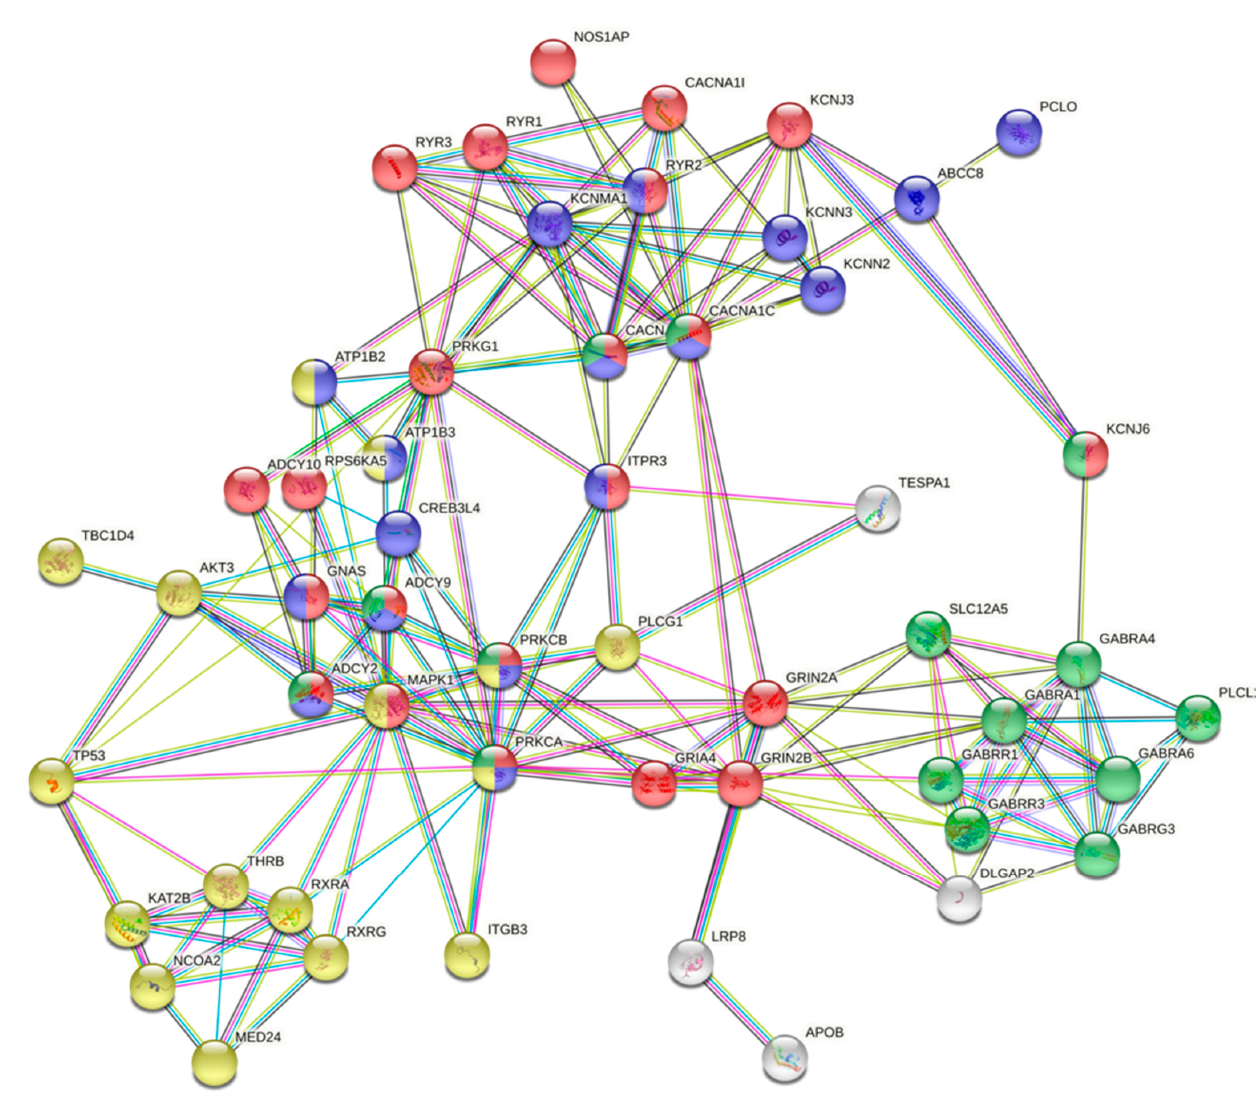
Figure 3. Protein–protein interaction network between gene products with high-impact variants contained in the top enriched pathways and those presenting differentially methylated sites in CLZ-treated patients. Proteins are grouped by colors according to the pathway they are involved in (e.g., proteins in red: circadian entrainment; blue: insulin secretion; yellow: thyroid hormone signaling pathway; green: GABAergic synapse). Clusters are based on STRING analysis. The center of the figure highlights the close interactions between